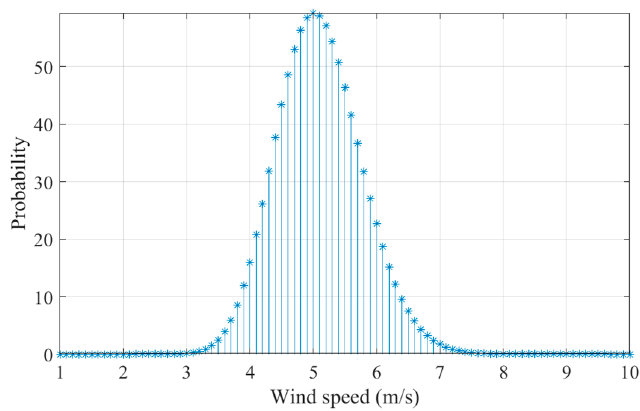
Figure 9. Probability density function of wind speed at hour 18.